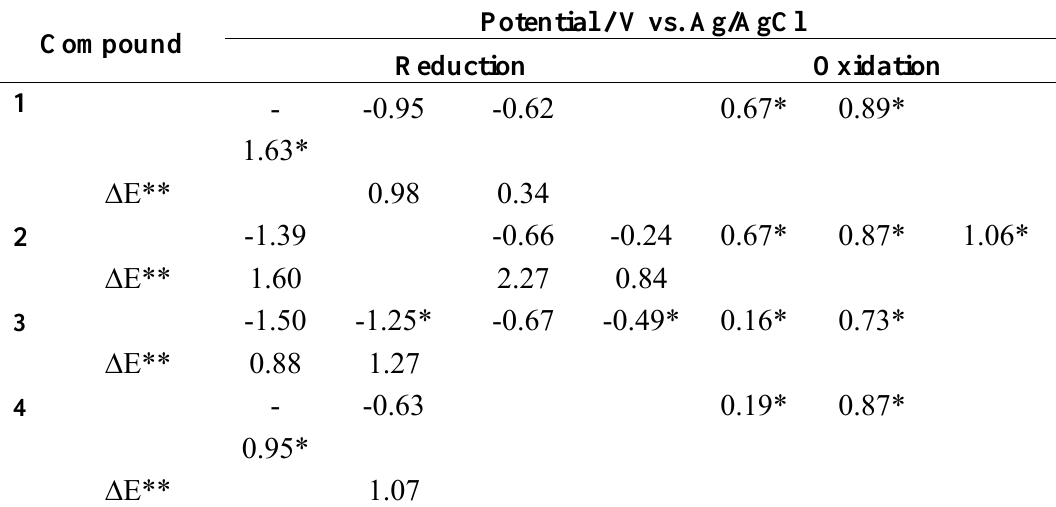
Table 5. Redox potentials of cobalt phthalocyanine